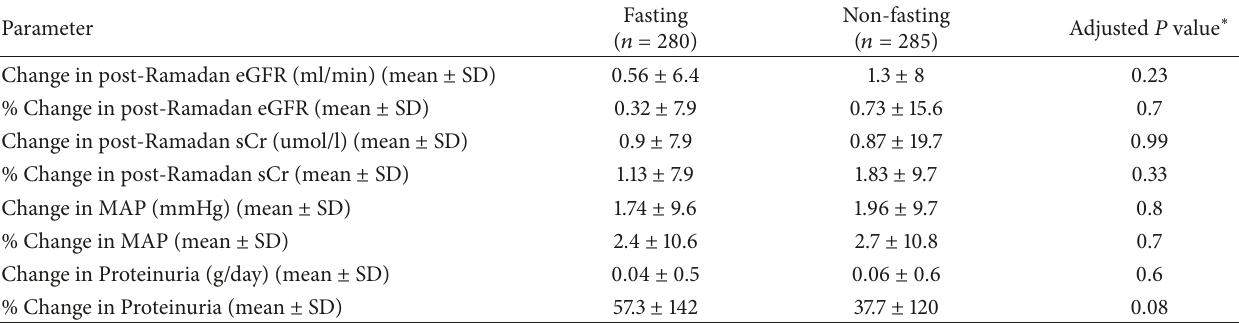
Table 3: Changes in eGFR, creatinine, MAP, and protein excretion between baseline and after Ramadan a , b in the fasting versus non-fasting